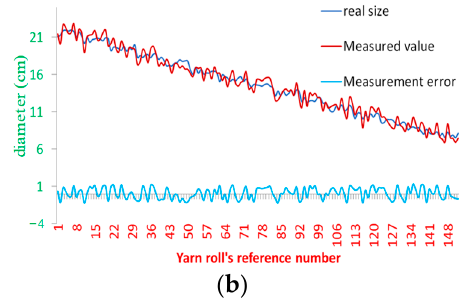
Figure 16. Kalman filter effect. In the fourth experiment, Formulas (1) and (2) are used to calculate the yarn roll’s margin. During the calculation, the measurement error of the diameter will be magnified. Here, the error value of the margin is not used as an evaluation index, but only for statis- tics. For the cylindrical yarn roll, ten cylindrical yarns with diameters of 22 cm, 21 cm, 20 cm, etc., are taken and the margin calculated as a measured value through the above method. Then, we predict the current margin according to the yarn consumption speed and combine the two values through the Kalman filter as the final result. Figure 17a shows the detection error of long cylindrical yarn roll margin, and there are ten groups of data for which the average error is calculated at each sampling point. The conical yarn roll is also sampled and measured. The final error is shown in Figure 17b. The errors are all absolute values, so there are no negative numbers.